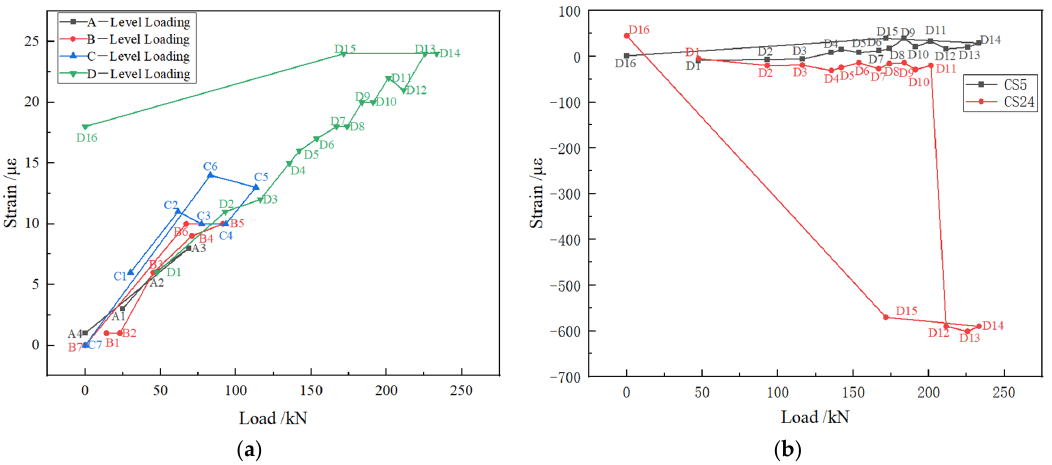
Figure 13. Strain of floor and side wall. ( a ) strain of floor; ( b ) strain of side wall.